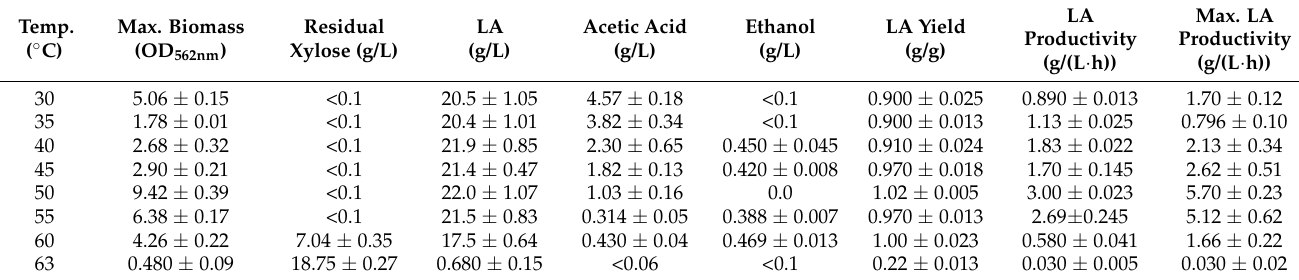
Table 1. Effect of temperature on lactic acid (LA) fermentation efficiency by Bacillus coagulans Azu-10. Temp. Max. Biomass ( ◦ C) (OD 562nm